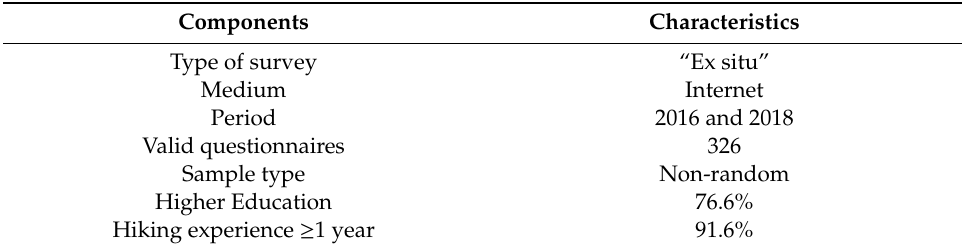
Table 1. Technical specifications of the